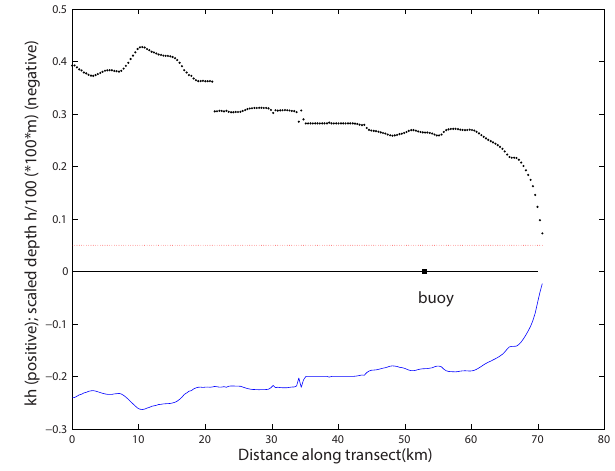
Figure 14. Test-case 1: kh and depth h along the transect in Fig.